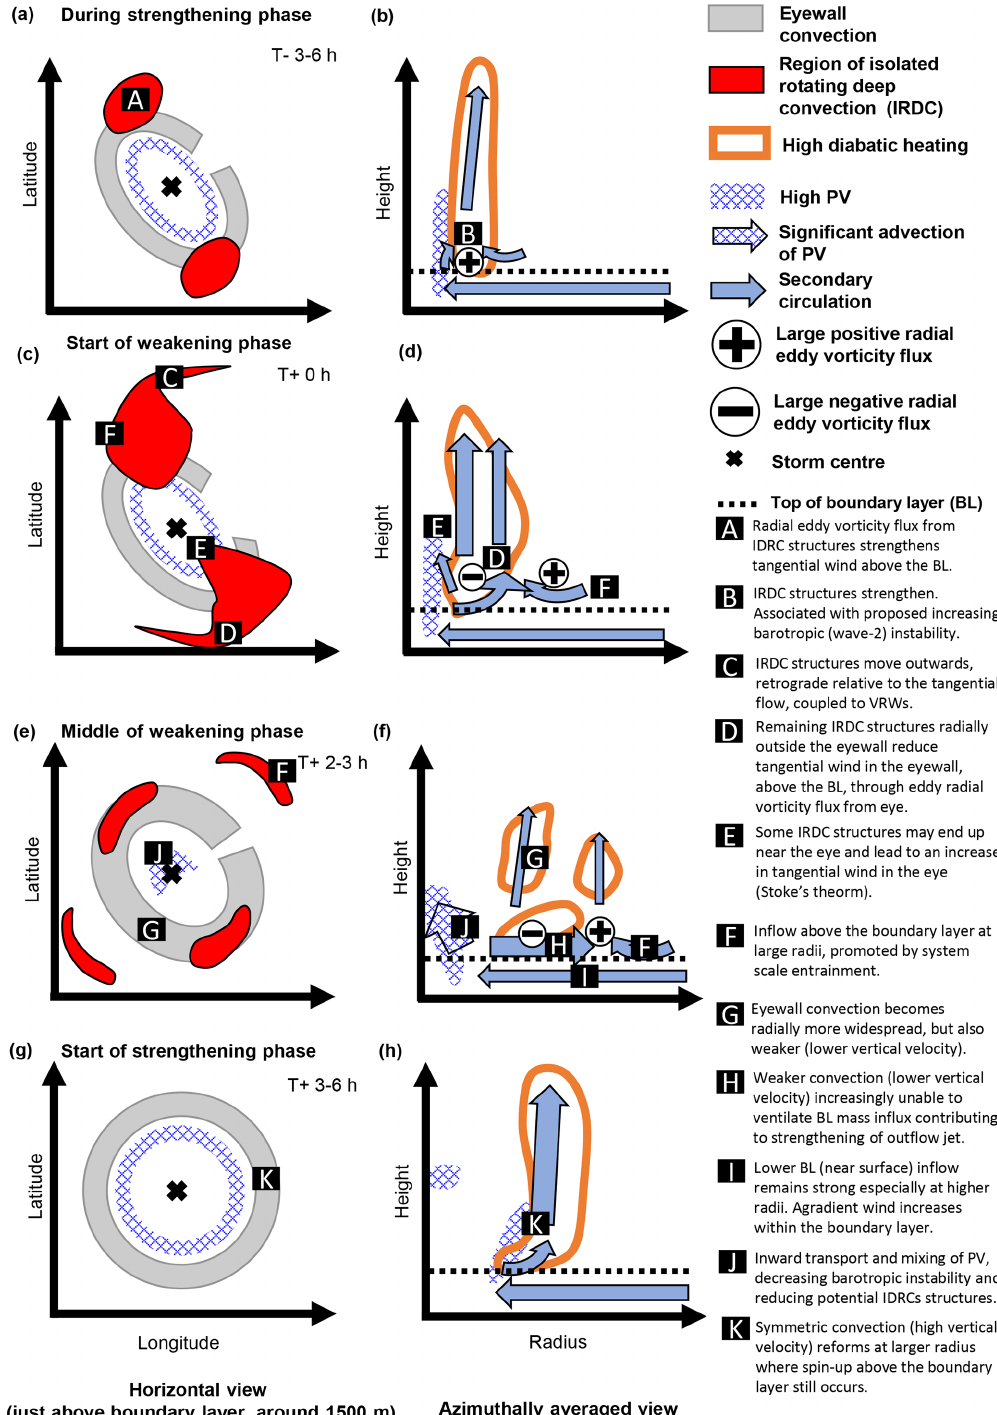
Figure 19. Schematic outlining the proposed mechanism for the fluctuations modelled during the rapid intensification of Hurricane Irma during (a, b) the end of a strengthening phase, (c, d) the middle of a weakening phase, and (e, f) the start of the strengthening phase. Panels (a, c, e, g) show the horizontal structure. Panels (b, d, f, h) show the azimuthally averaged structure of the storm at each stage, with arrows indicating the direction of the secondary circulation (larger arrows imply stronger